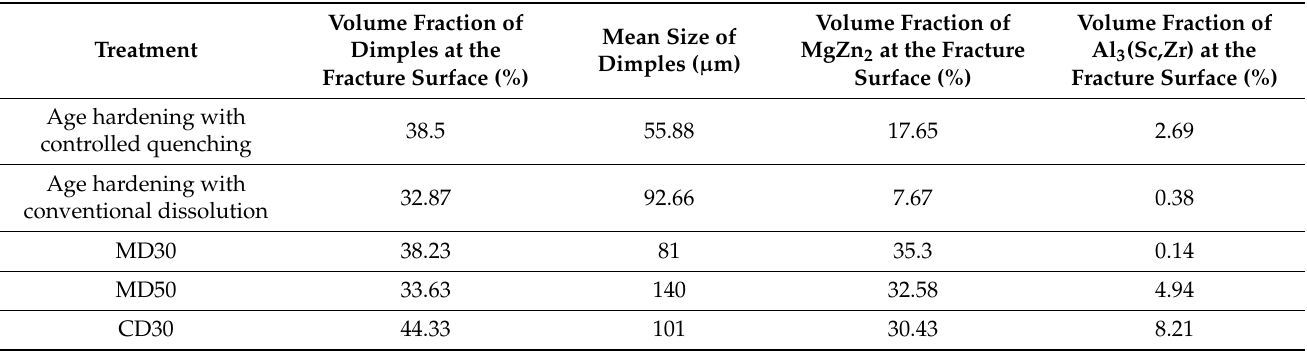
Table 8. Comparative results of analysis of dimples on the fracture surface using MIP